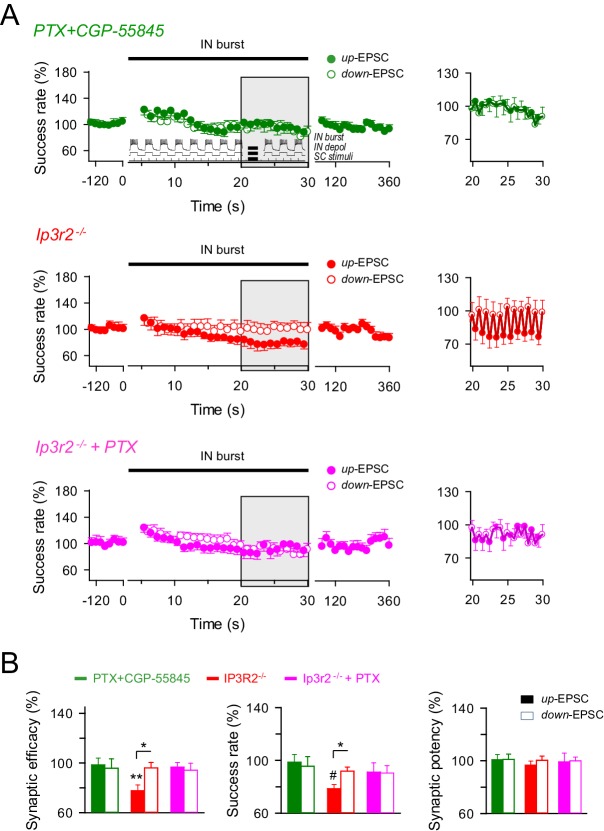
GABAA and GABAB interplay in the astrocyte-interneuron modulation of the excitatory synaptic transmission.(A) Left, averaged relative success rate of up-EPSCs (closed circles) and down-EPCSs (open circles) evoked by the stimulation protocol described in Figure 5 (inset) over time in wild-type mice in the presence of picrotoxin plus CGP55845 (PTX+CGP; green), and in Ip3r2-/- mice in control (red) and in the presence of picrotoxin (PTX; pink). Each point represents the simple moving average of 15 consecutive EPSCs. Horizontal bars indicate the time of pairing. Right, expanded view of gray-shaded areas. (B) Relative changes of synaptic parameters for up-EPSCs (filled bars) and down-EPSCs (open bars) in wild-type mice in the presence of picrotoxin plus CGP55845 (PTX+CGP; green; n = 9; p=0.81 (synaptic efficacy up); p=0.61 (synaptic efficacy down); paired t test), and in Ip3r2-/- mice in control (red; n = 7; p=0.004 (synaptic efficacy up); p=0.37 (synaptic efficacy down); paired t test) and in the presence of picrotoxin (pink; n = 10; p=0.46 (synaptic efficacy up); p=0.35 (synaptic efficacy down); paired t test). *p<0.05, **p<0.01, #p<0.001. Error bars indicate SEM.